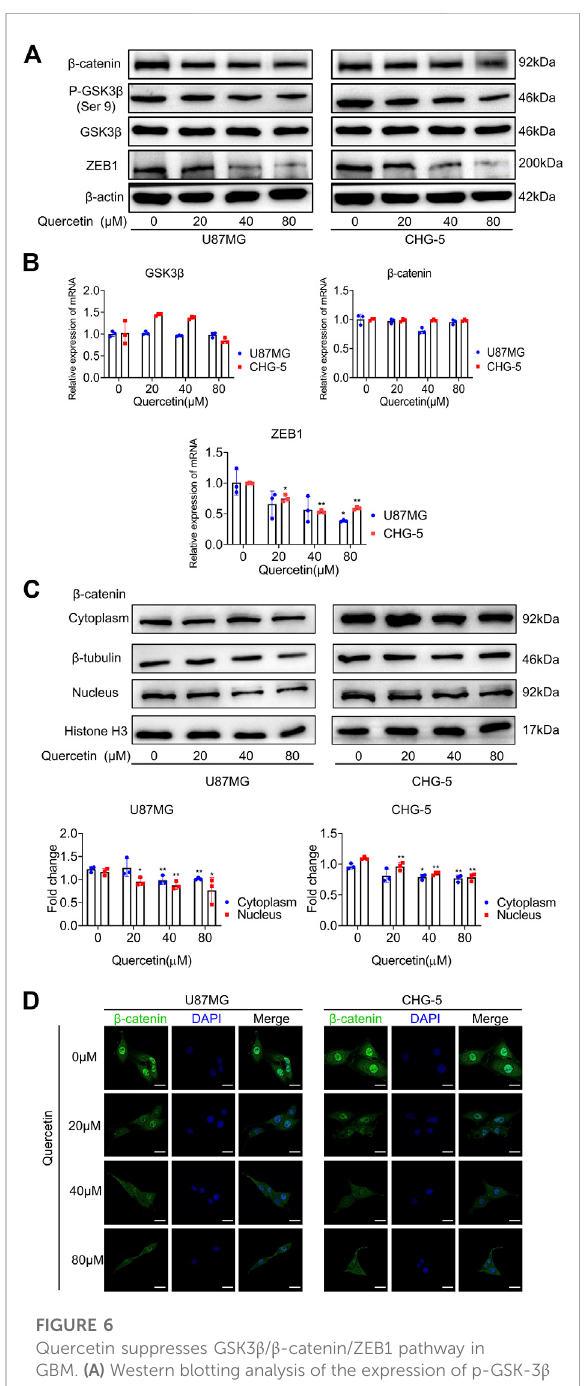
FIGURE 6 Quercetin suppresses GSK3 β / β -catenin/ZEB1 pathway in GBM. (A) Western blotting analysis of the expression of p-GSK-3 β (Ser9),GSK-3 β , β -catenin,andZEB1aftertreatmentwithquercetin (0, 20, 40, 80 μ M) in U87MG and CHG-5 cell lines. The data are shown as the mean ± SD of three experiments. (B) RT-qPCR was used to examine the mRNA levels of GSK-3 β , β -catenin, and ZEB1 after treatment with quercetin (0, 20, 40, 80 μ M) in U87MG and CHG-5 cell lines. All data areshown as the mean± SD ofthree experiments. * p ＜ 0.05, ** p ＜ 0.01 v s. control group. (C) Western blotting was used to detect the expression of β -catenin in cytoplasm and nucleus of U87MG and CHG-5 cell lines treated with quercetin (0, 20, 40, 80 μ M). The data are shown as the ( Continued